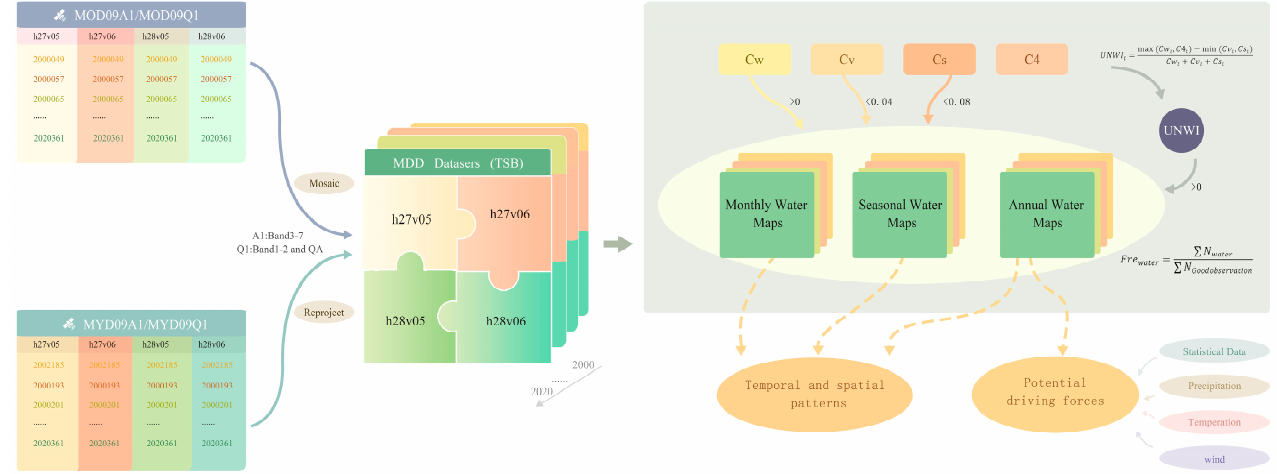
Figure 2. Work flow of this study (where C w , C v , C s , and C 4 are the decomposition coefficients for water, vegetation, soil, and yellow leaves, respectively; see Section 3.2, and 2002185, 2000193 . . . , 2020361 represents for the 185th day of the year 2002, 193th day of the year 2000, . . . , 361th day of the year 2020, respectively).